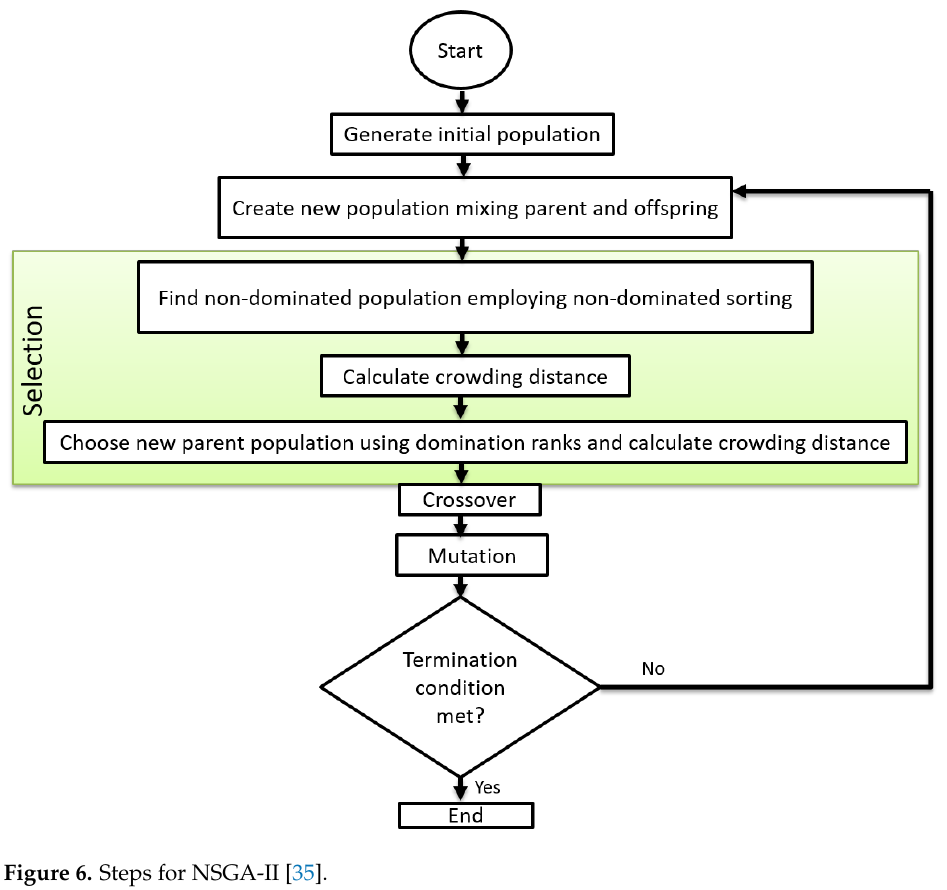
Figure 6. Steps for NSGA-II